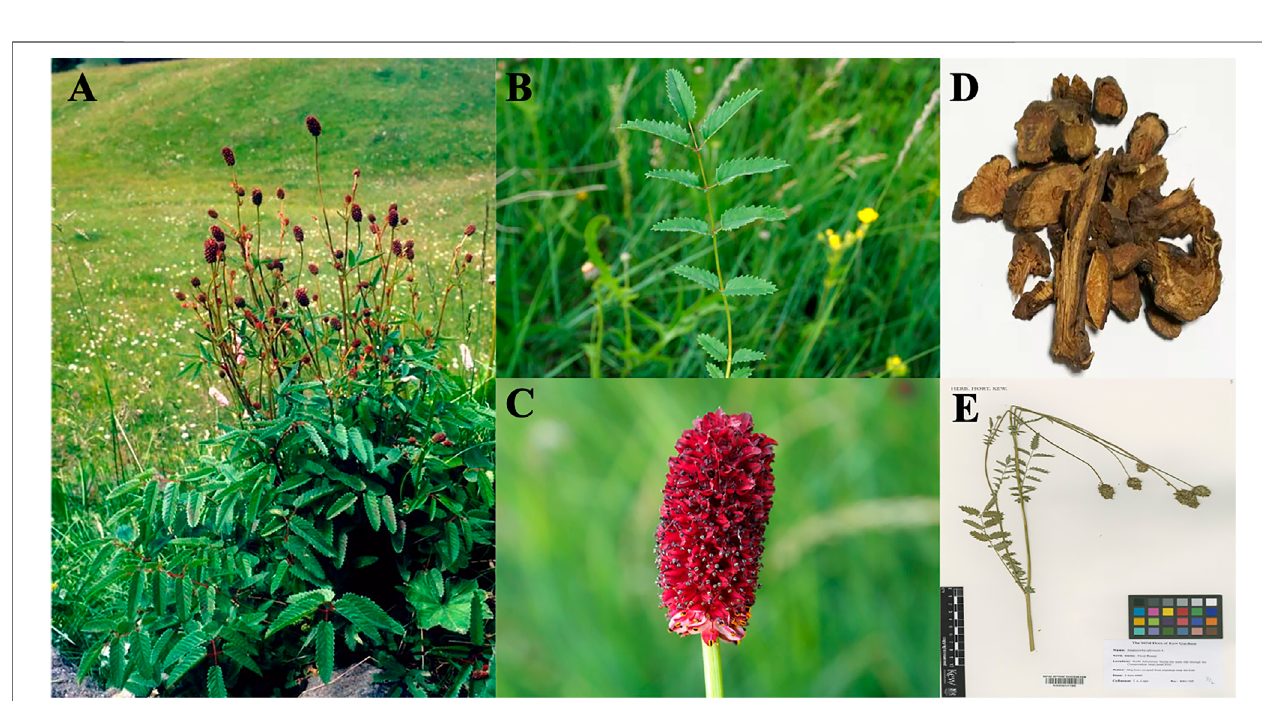
FIGURE 3 | Sanguisorba of fi cinalis L. Plants (Kew Botanical Garden, 2021a). The whole plant of S. of fi cinalis (A) ; the leaves of S. of fi cinalis (B) ; the fl ower of S. of fi cinalis (C) ; Sanguisorbae Radix (D) ; specimen of S. of fi cinalis (E) .